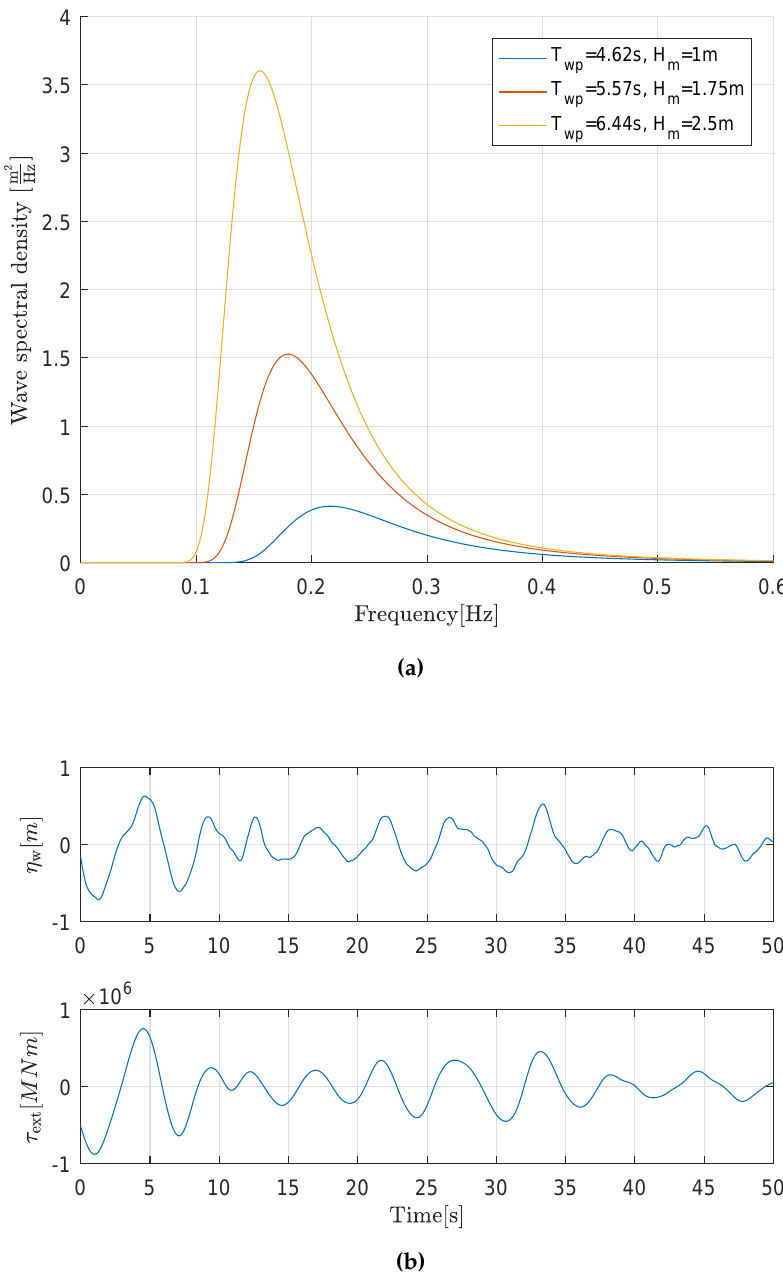
Figure 2. Sea state model: ( a ) Pierson-Moskowitz spectrum for three sea states and ( b ) example of wave height and excitation torque in time domain for T wp = 4.62 s and H m = 1 m.